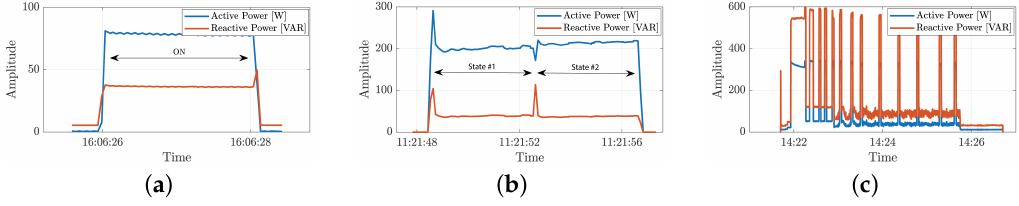
Figure 8. Electricity consumption of three types of devices. ( a ) On/Off device: hair curler; ( b ) FSM device: blender; ( c ) CVD: 3D printer.